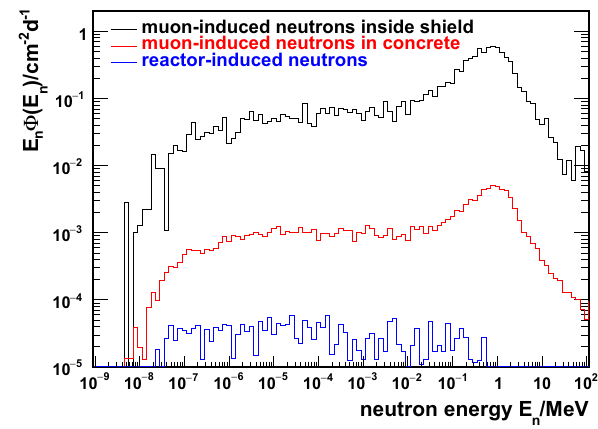
Fig. 28 Comparison of MC neutron spectra at the HPGe diode from various